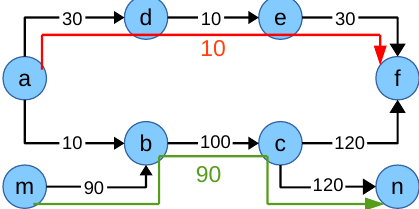
Figure 12. Scenario as in Figure 11, but NFF-objective-IV prevents flow [ a,f ] from using multipath and assigning link [ b,c ] to flow [ m,n ] resulting in poor